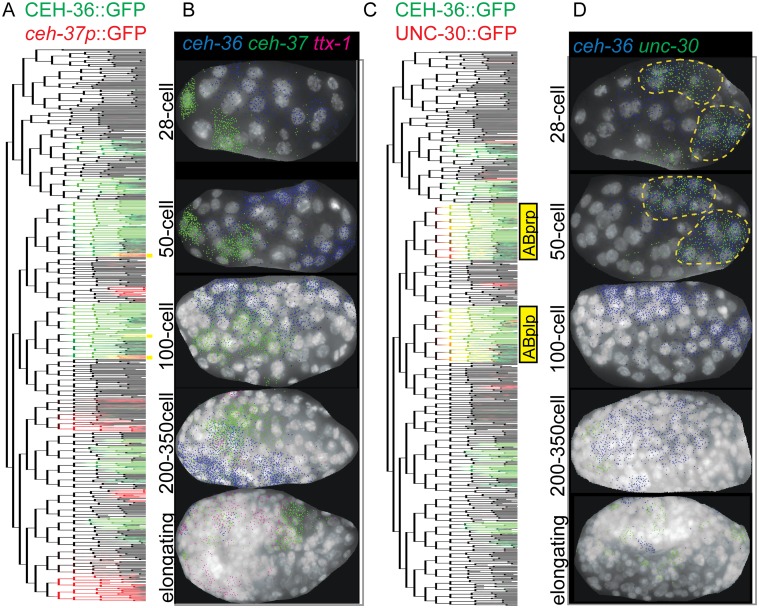
Embryonic coexpression patterns of C. elegans OTX and PITX factors.A, B) Expression overlap of (A) CEH-36::GFP and ceh-37 promoter::GFP or (C) CEH-36::GFP and UNC-30::GFP mapped onto a reference lineage [21]. Cells with overlapping expression are SAAV(L/R), AWC(L/R), DB1, DB3, RMEV and the excretory duct, pore and canal cells. RMEV and the canal cell have sustained ceh-36 expression joined later by ceh-37, while all others express first the ceh-36 reporter, then the ceh-37 reporter, with minimal temporal overlap. B, D) Coexpression of RNA as identified by single molecule RNA-FISH [43] at various stages for (C) ceh-36, ceh-37 and ttx-1 or (D) ceh-36 and unc-30 in embryos at the indicated stages.